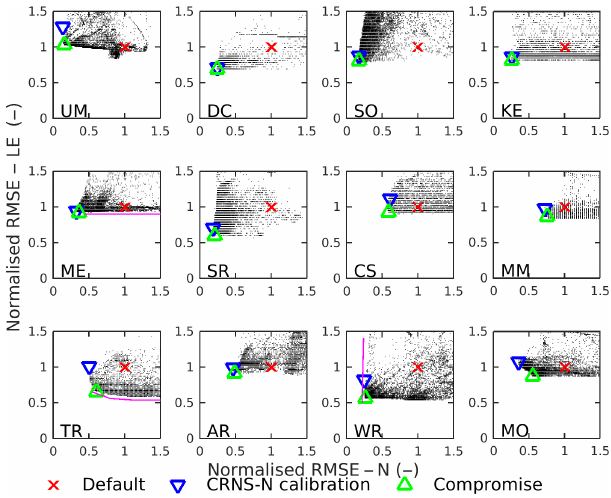
Figure 10. Same as Fig. 9 but for the two-objective calibrations against CRNS neutron counts (representing soil moisture) and day- time hourly latent heat flux (LE) at each